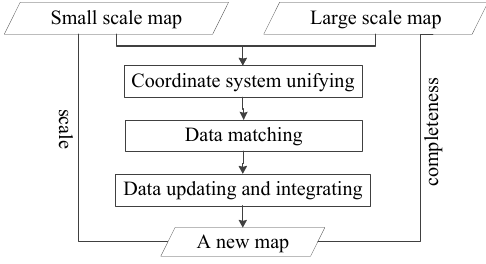
Figure 1: The framework of multi-scale thematic maps